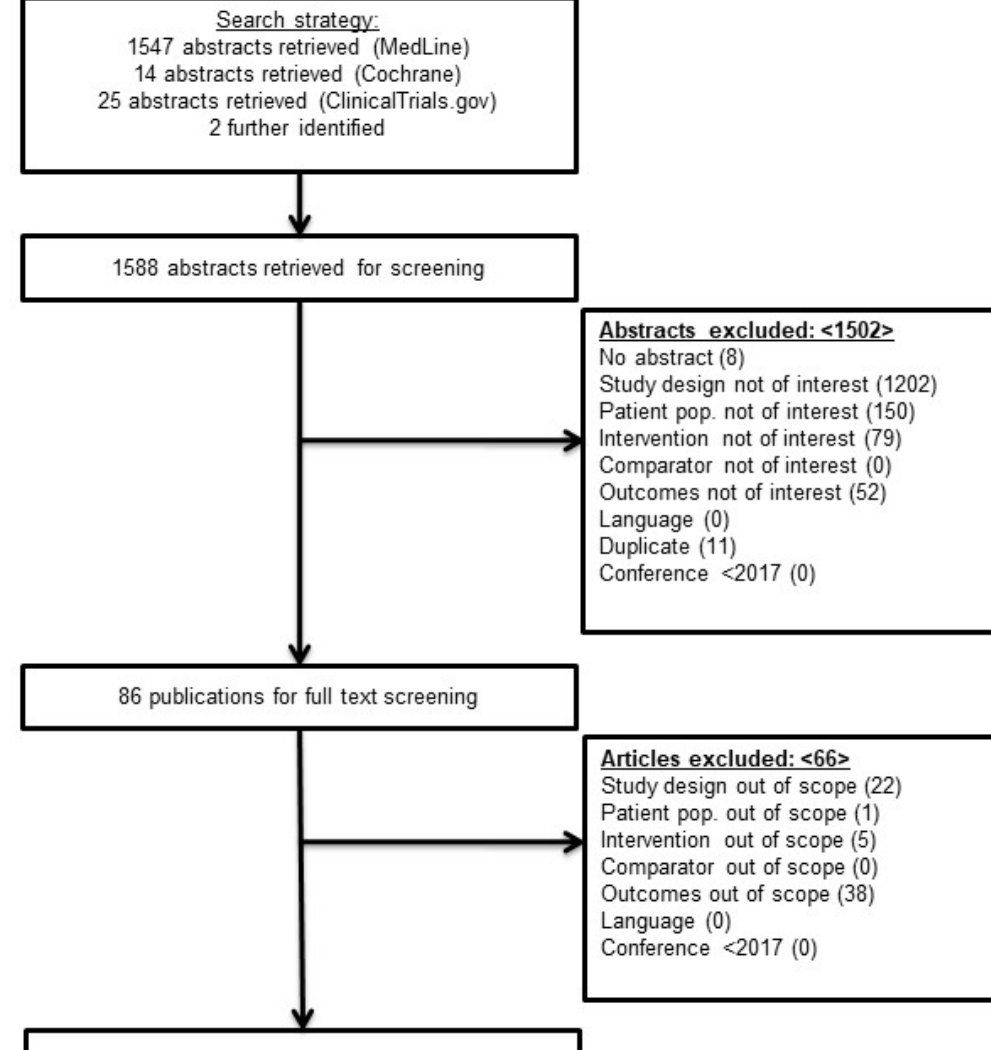
Figure 1. Study selection – Shock. Pop. =